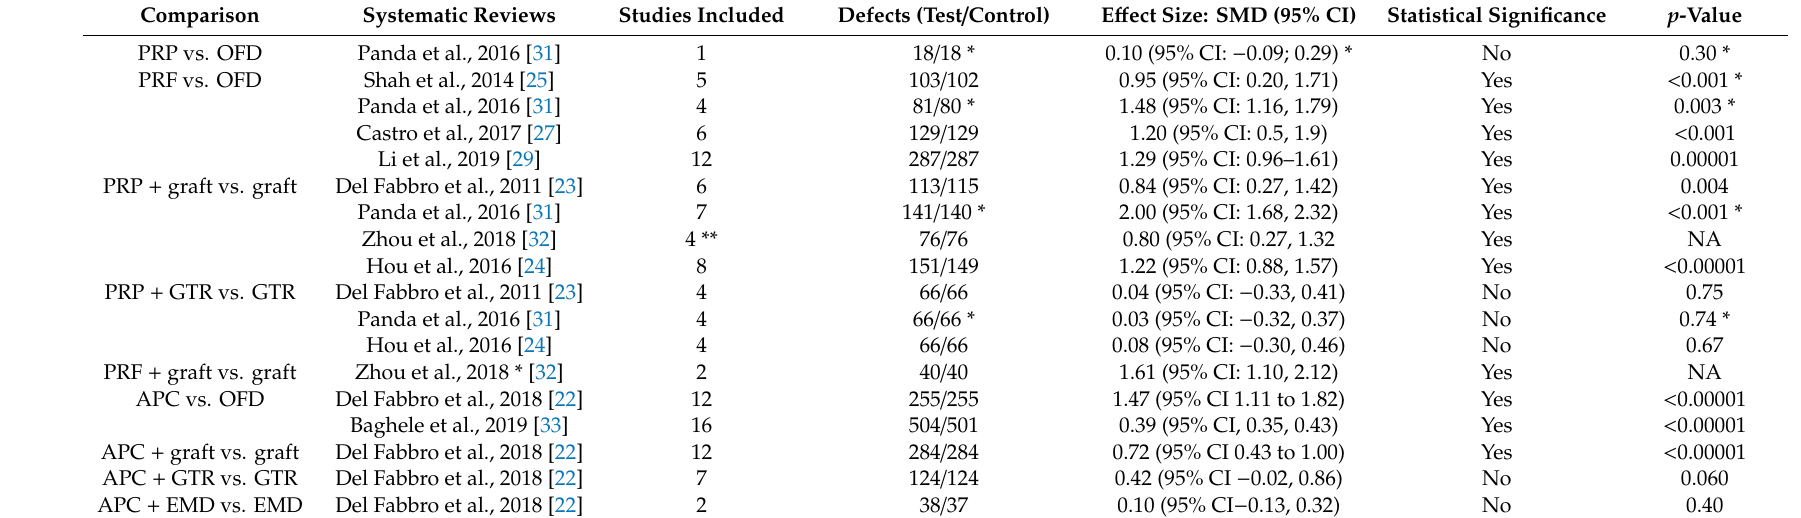
Table 5. Overall e ff ect size for CAL